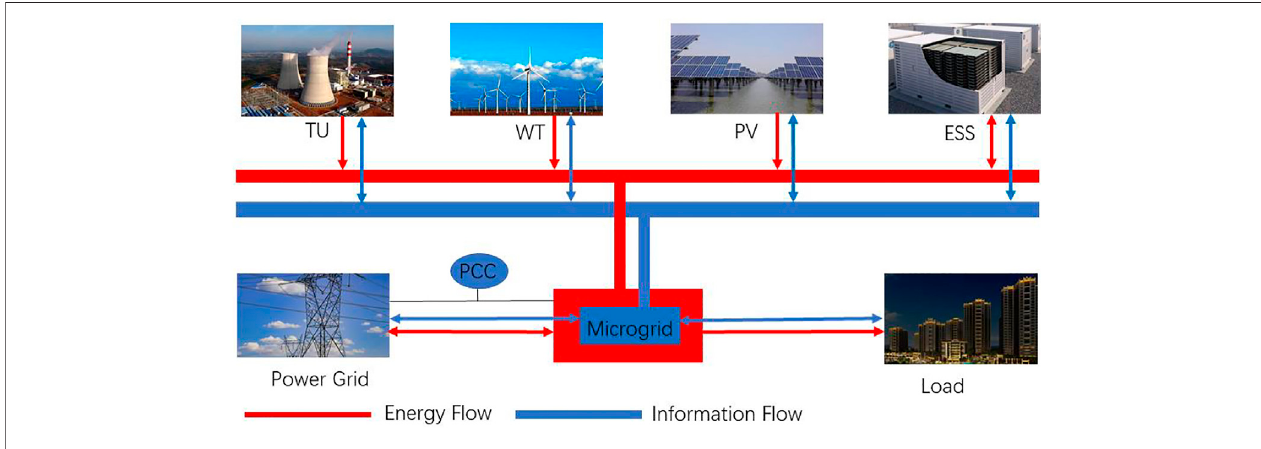
FIGURE 1 | Structure of